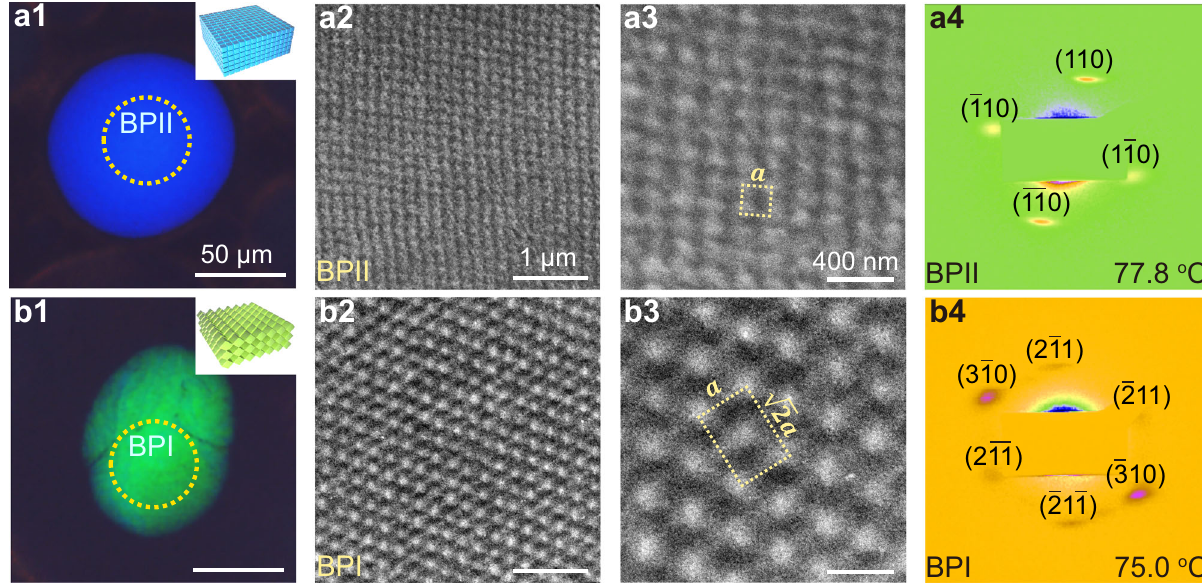
Fig. 2 TEM images and syn-SAXS analysis of the monophases of BPI and BPII. a 1 , b 1 Textures observed in re fl ection mode using cross-polarized microscopy. The yellow circle highlights the monophase or interface in core-shell con fi gurations. The inserts in a 1 , b 1 are schematic illustrations of the arrangements of cubic cells at the interfaces of BPIII, BPII, and BPI or monophasic BPII and BPI. TEM images of a 2 , a 3 BPII, b 2 , b 3 BPI. a 4 , b 4 Syn-SAXS patterns with background subtracted from a monodomain a 4 BPII {100} , b 4 BPI {110} .